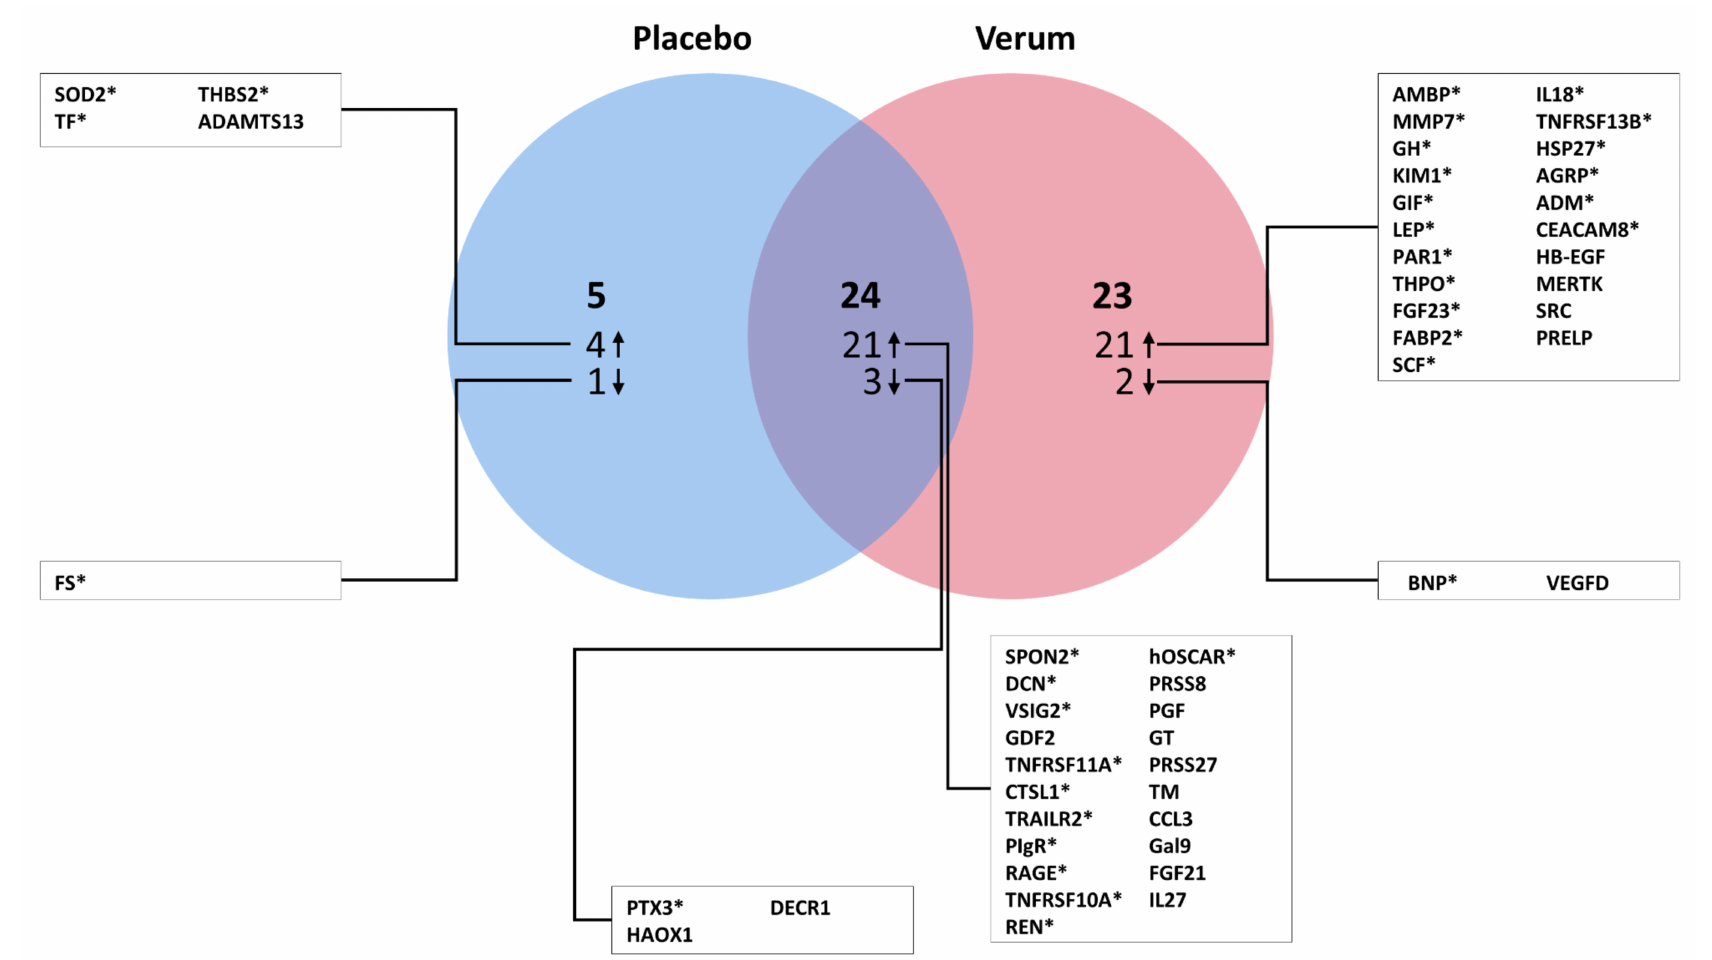
Figure 1. Expression changes of plasma biomarkers following spironolactone or placebo treatment in HFpEF. The Venn diagram shows plasma biomarkers with significant expression changes from baseline (BL) to twelve-month follow-up (FU) in the placebo group, the verum group and in both groups (corrected for age and sex). * indicates that statistical significance remains after adjustment for multiple testing (in the combined group, this implied that significance remained in both the placebo and verum